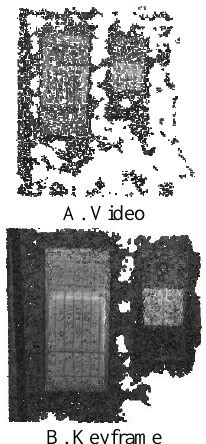
Figure 10 . The output of the generation of the 3D thermal dense point cloud of the evaluation dataset. Figure (10. A) Depicts the output of the thermal infrared 3D dense point cloud of the evaluation dataset in video mode, and figure (10. B) Illustrates the output of the 3D dense